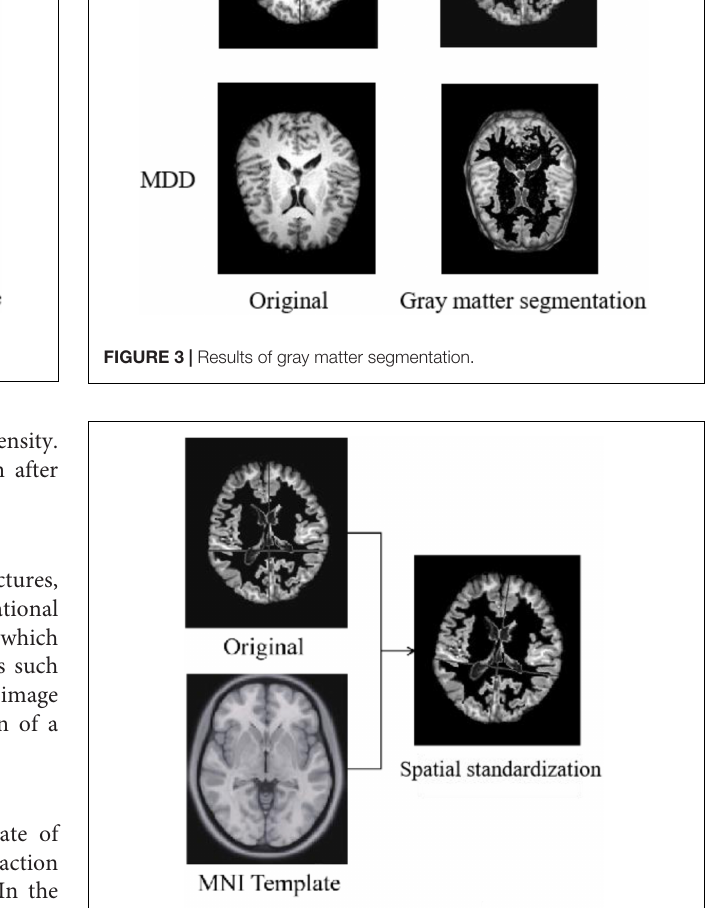
FIGURE 4 | Results of spatial